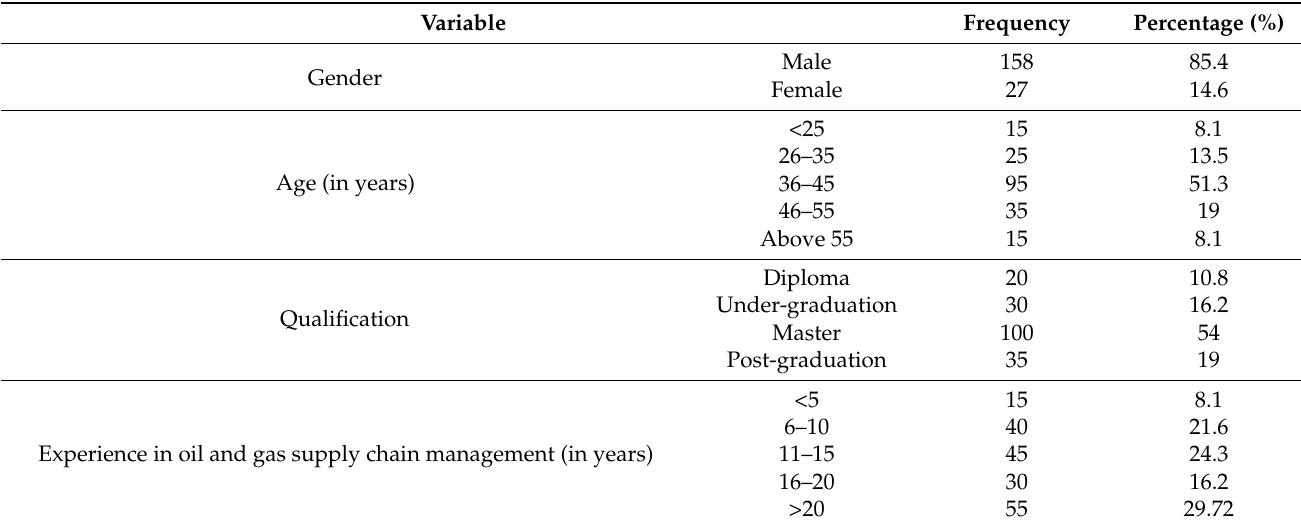
Table 2. Respondent profile.